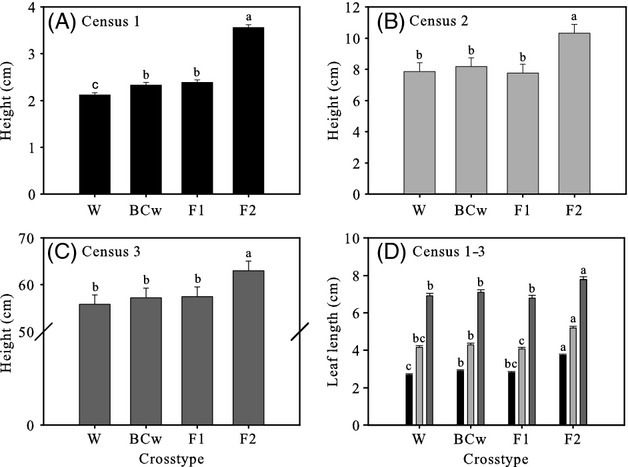
Least squares means for height of W, BCw, F1, and F2 sunflower crop–wild hybrid cross types at (A) census 1 (n = 2573), (B) census 2 (n = 2562), and (C) census 3 (n = 2550). (D) Least squares means for length of longest leaf for W, BCw, F1, and F2 sunflower cross types at census 1 (black bars; n = 2511), census 2 (light gray bars; n = 2557), and census 3 (dark gray bars; n = 2546). Values are means + 1 SE. Cross types that are marked with the same letter are not significantly different at the 0.05 level using a Tukey–Kramer adjustment for multiple comparisons. BCw–F1 backcrossed onto a wild parent. Note differences in scale on the y-axes.